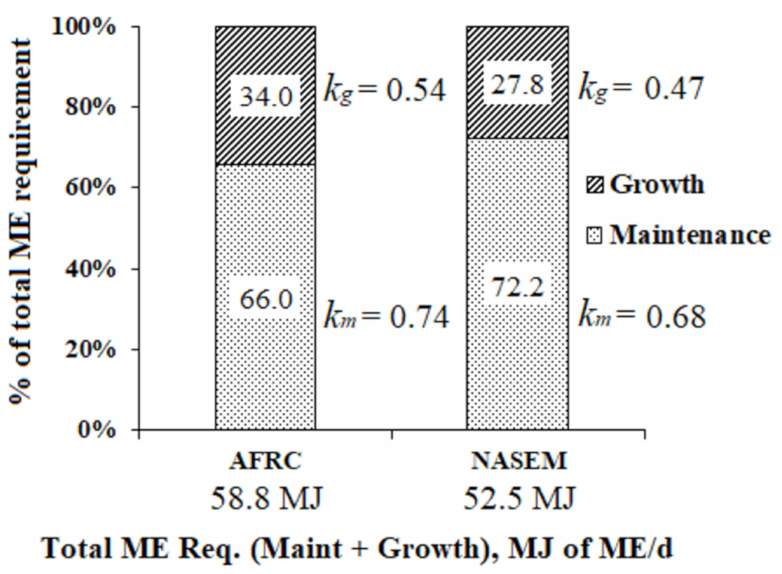
Figure 3. Simulation of total ME requirement calculated by equations within two feeding systems: AFRC [2], and NASEM [13] by taking an example provided by Gordon et al. [41]. Observed MEI = 0.81 MJ/kg 0.75 (total MEI = 74.6